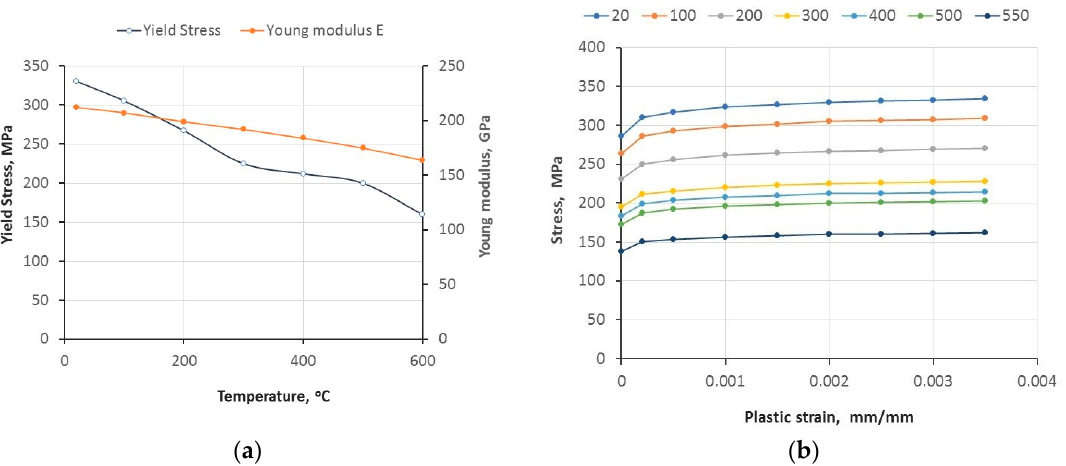
Figure 6. The assumed mechanical properties ( a ) and temperature-dependent stress–plastic strain curves ( b ) calculated on the basis of static tensile tests.